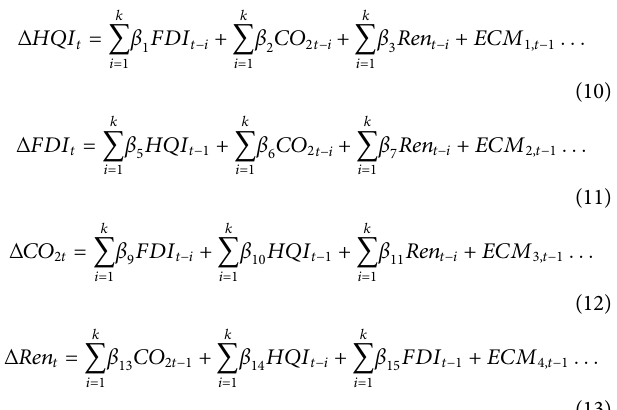
TABLE 3 Dependent variable: HQI.